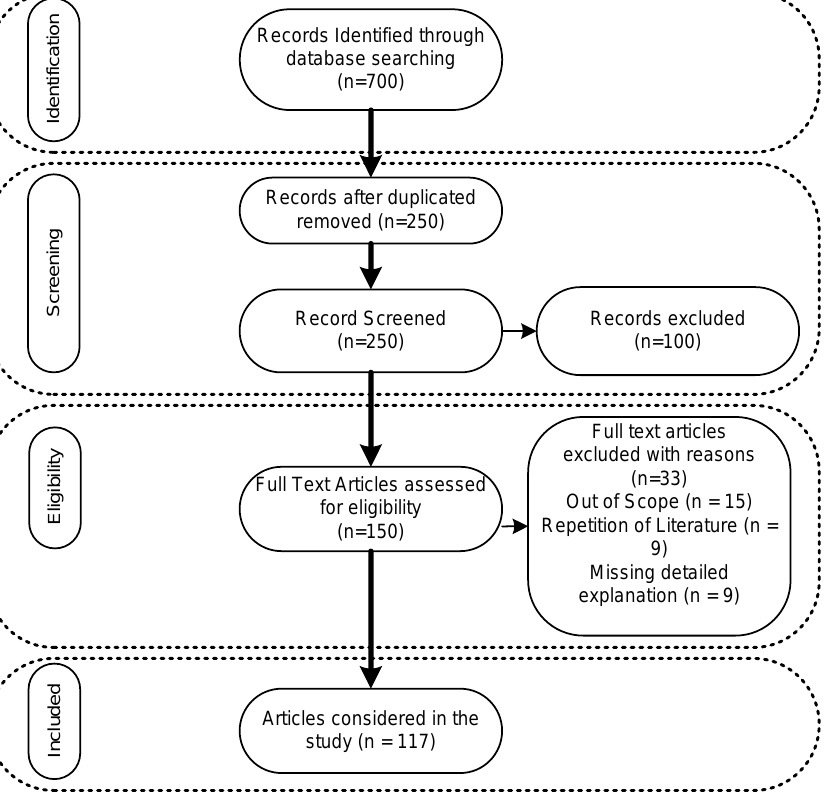
Figure 1. PRISM framework.